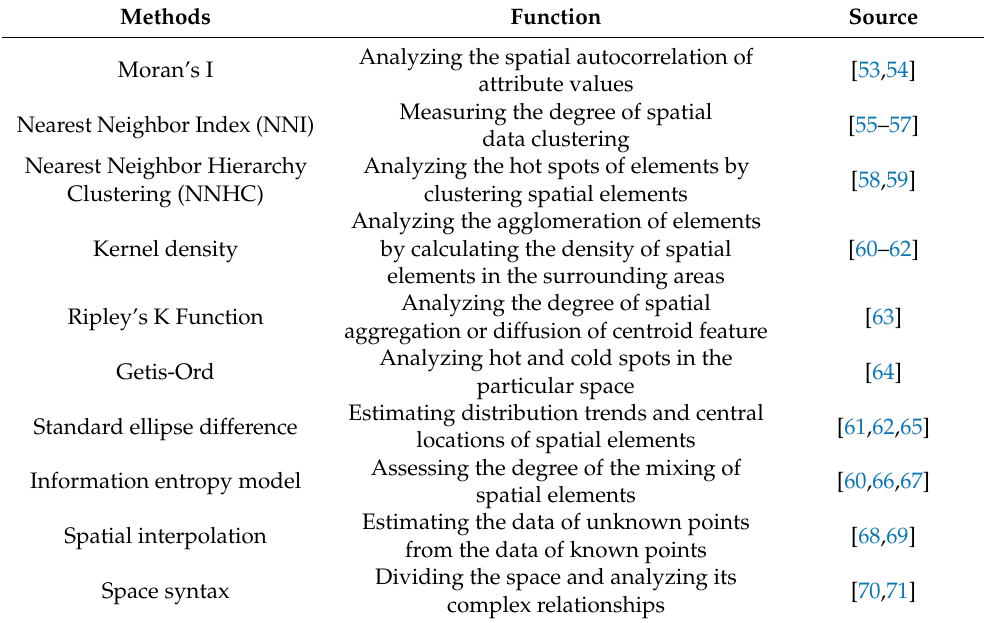
Table 1. Spatial characteristic analysis